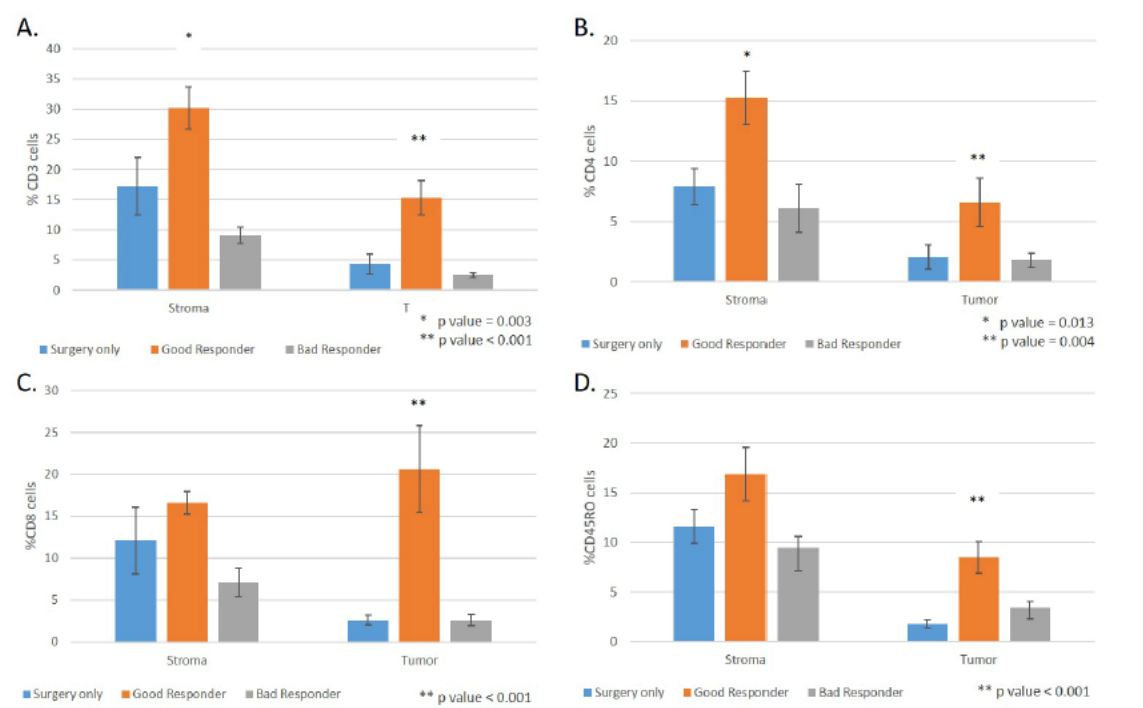
Figure 4. Densities of different lymphocytes subpopulations quantified from immunohistochemistry slides and compared between the different groups in the cohort: surgery only (blue), good responders (orange), and bad responders (grey). The lymphocytes subpopulations presented are: ( A ) . T cells (CD3) ( B ). T helper cells (CD4), T cytotoxic cells (CD8) ( C ) . T cytotoxic cells (CD8) ( D ) . T memory cells (CD45RO). Data are presented as mean ± standard deviation; p -value was assessed by ANOVA test.